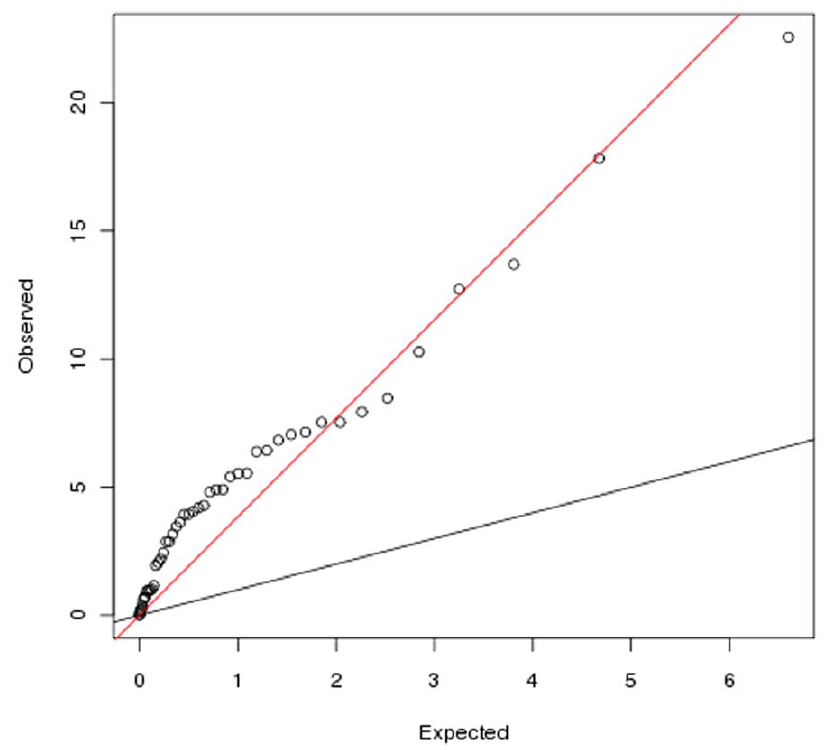
Figure 1. Quantile-Quantile plot of chi-square test of association p-values of 49 SNPs.